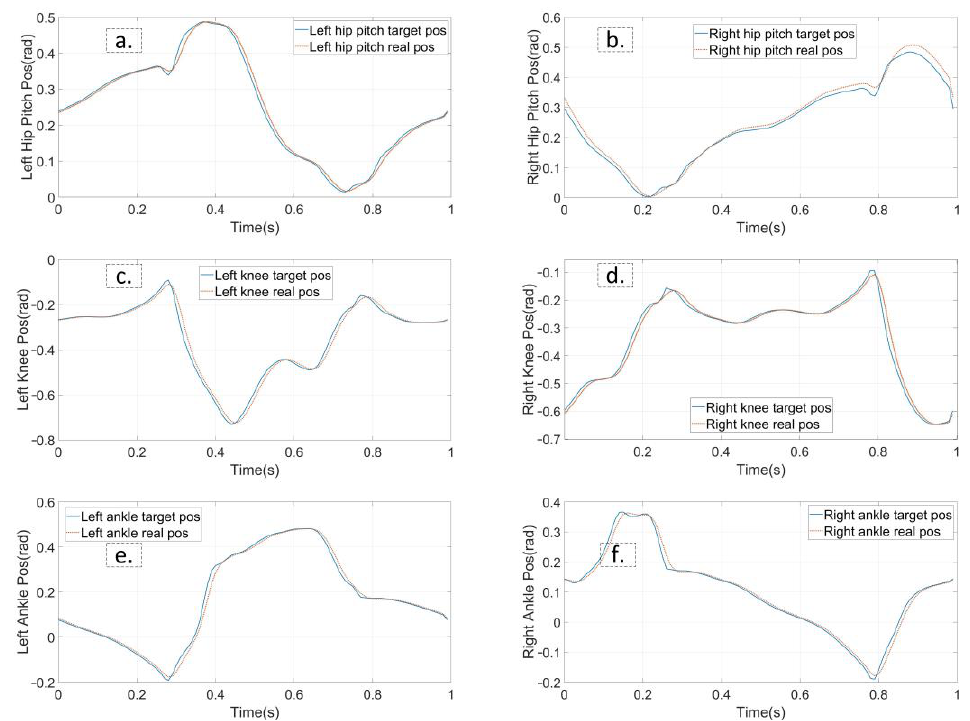
Figure 5. The planned input trajectory of planar walking on flat terrain.